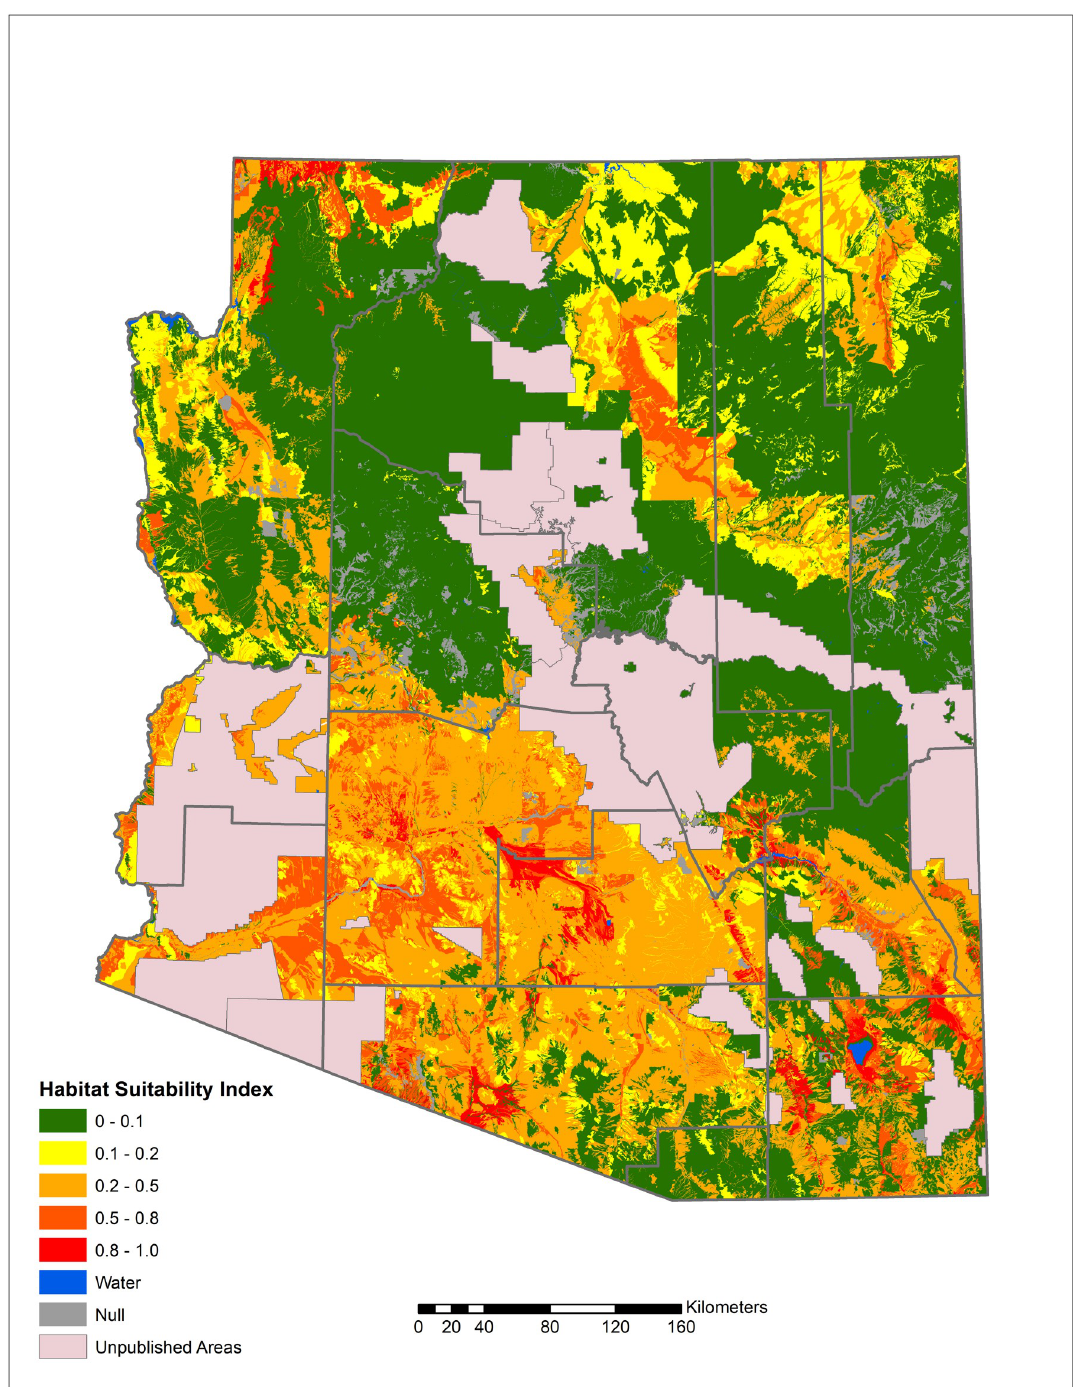
Fig 2. Predicted Coccidioides habitat suitability index for Arizona.